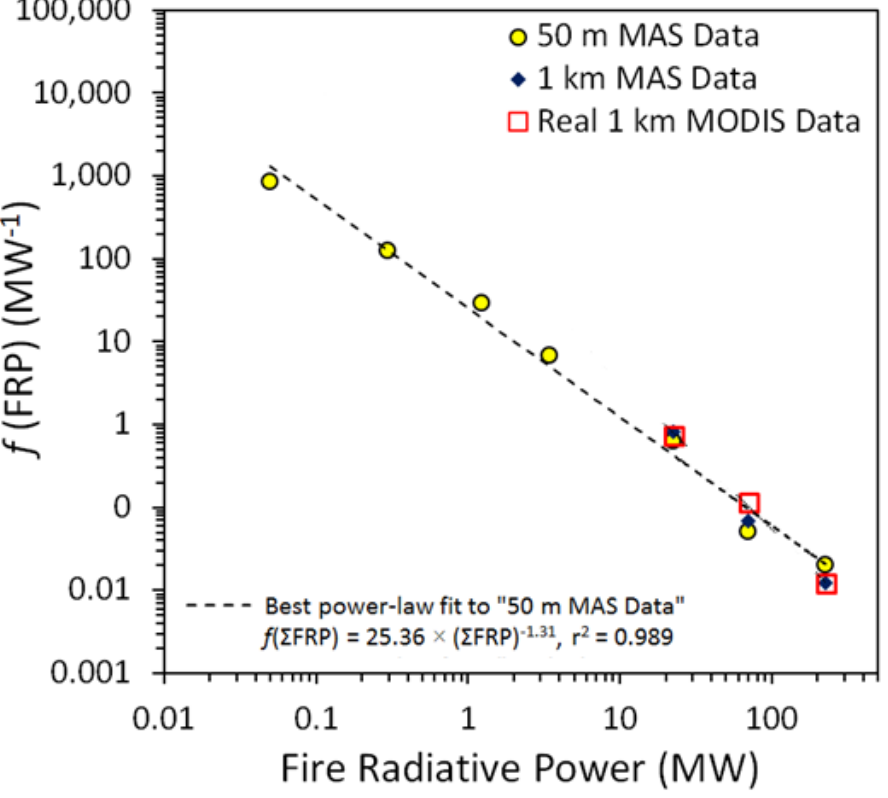
Figure 6. Frequency densities of the summed MAS-detected Fire Radiative Power [ f ( Σ FRP)] observations in the northernmost MAS flightline (Figure 1) flown in Sept 1995, shown as a function of FRP, for both the original 50 m spatial resolution MAS data (yellow filled circles) and that spatially degraded to 1 km (blue filled diamonds); see also Figure 3. The f ( Σ FRP) derived from real spaceborne AQUA MODIS (MYD14) data of the same area and time of year (in 2002) are noted as ‘real’ 1 km MODIS Data in the chart (non-filled red squares). The best-fit power-law fit to f( Σ FRP) as a function of Σ FRP is also given for the 50 m spatial resolution MAS dataset (dashed line and equation).